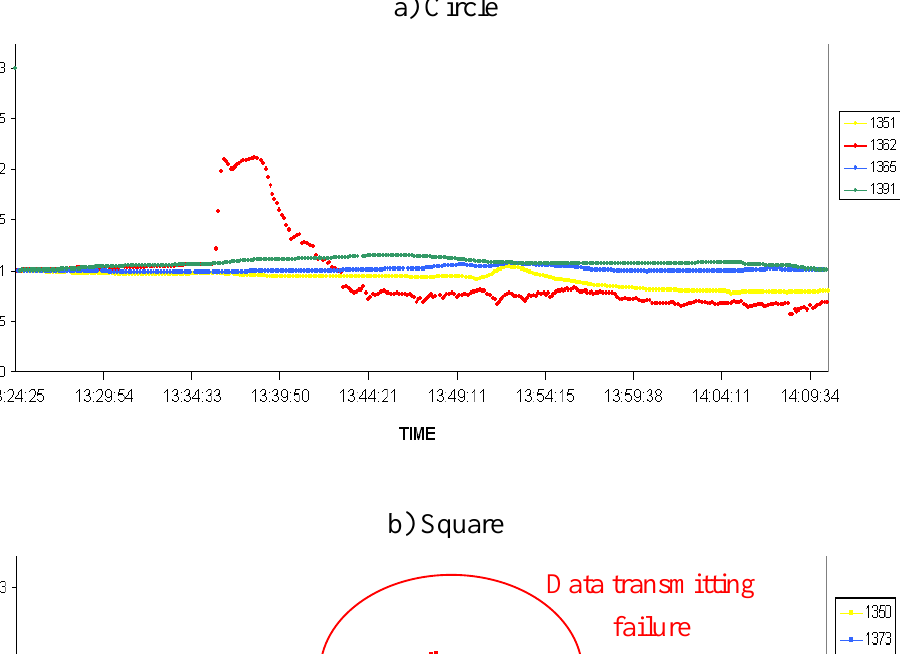
Figure 7. Humidity results of the 12 MICA2 3 rd GEN with a failure of nodes 1374 and 1390 without continuous data